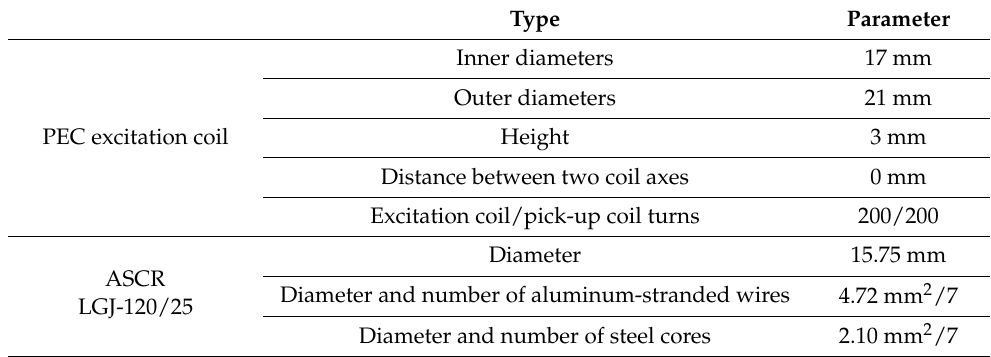
Figure 3. ( a ) Schematic diagram of the detection of broken strands in the transmission line based on pulsed eddy current; ( b ) the distribution of the current density during testing. Table 2. Parameters used in the simulation.